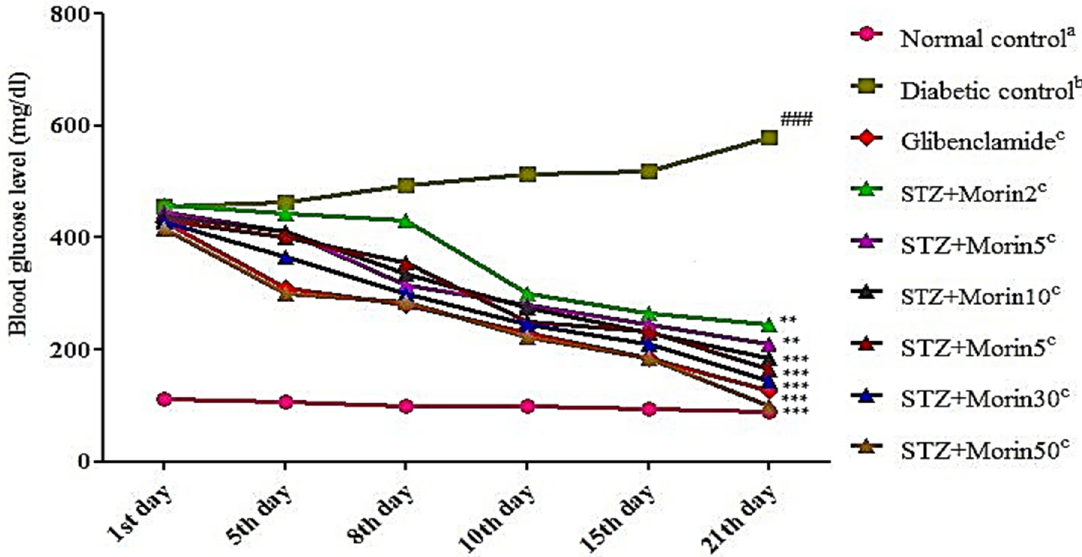
Figure 1. Effect of various treatments on blood glucose level in streptozotocin induced diabetic rats (the values are expressed as mean ± SEM. Each value corresponds to a mean of eight animals per group; ### p < 0.001; comparison of normal control a vs. diabetic control b using Student’s T -test, ** p < 0.01 and *** p < 0.001; comparison of diabetic control b vs. glibenclamide c and morin c treated groups using one way ANOVA followed by Dunnett’s post hoc multiple comparison test).